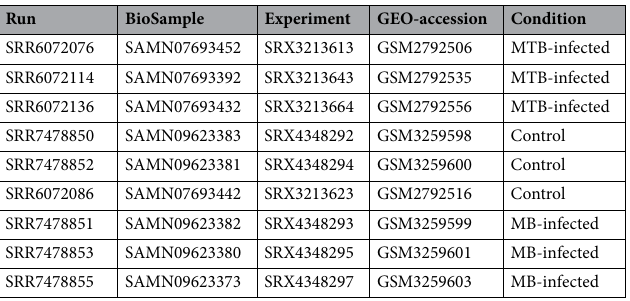
Table 1. List of transcriptome profiles from the GEO